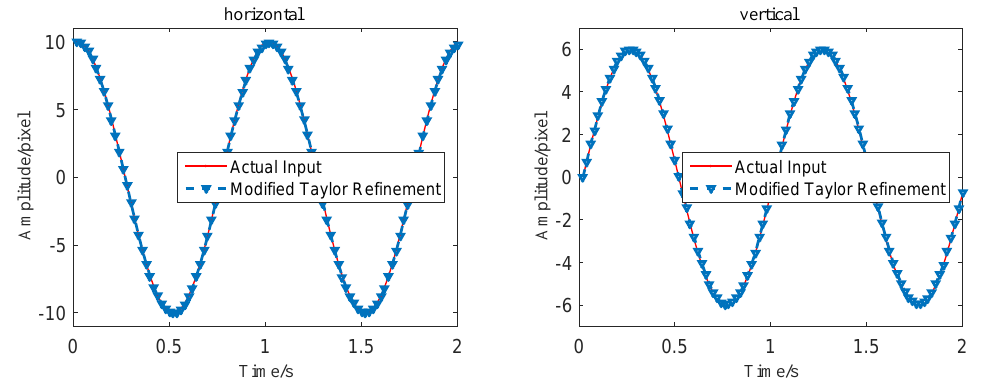
Figure 6. Comparisons of displacement extraction results between the actual input and the MCC with modified Taylor